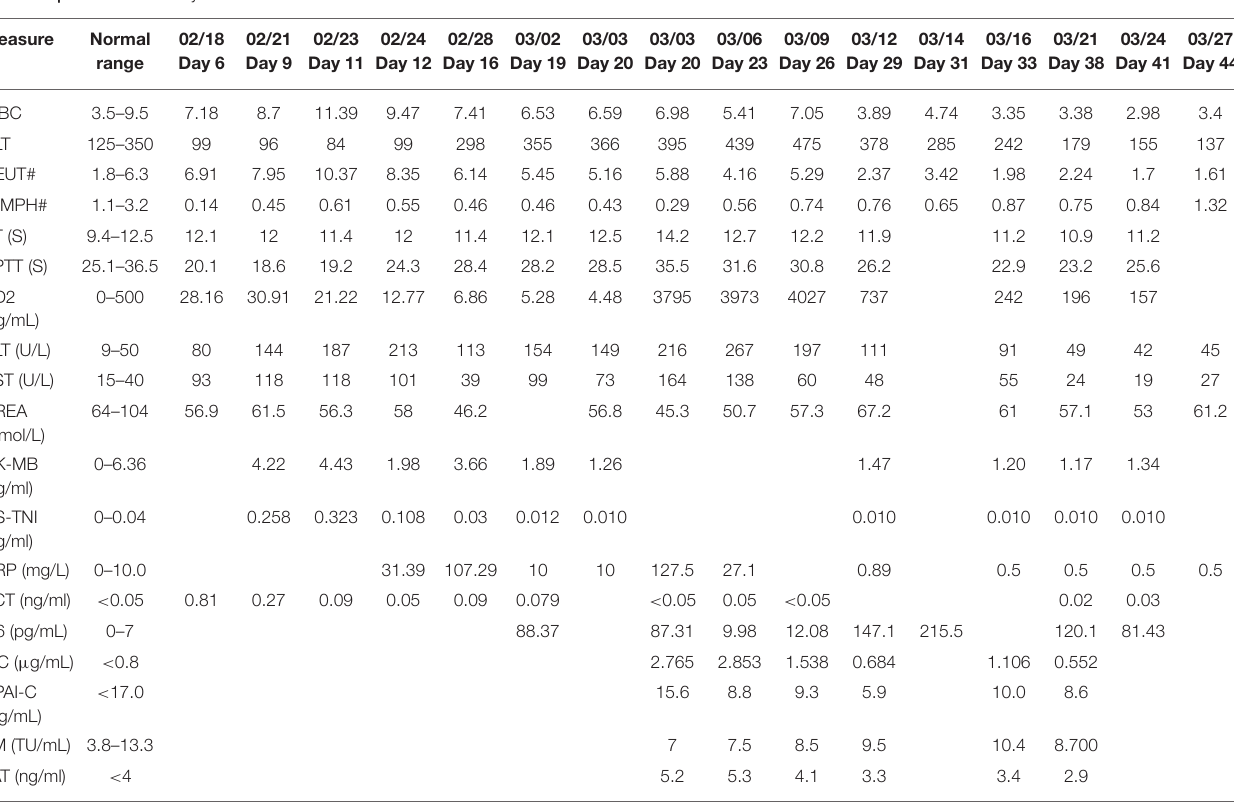
TABLE 1 | Clinical laboratory